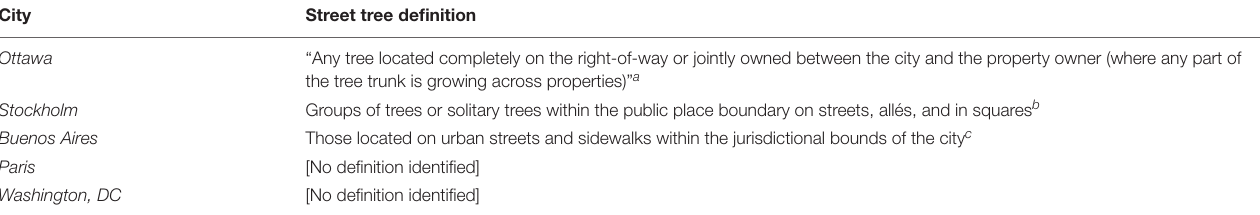
TABLE 2 | Local authority definitions of street trees in each